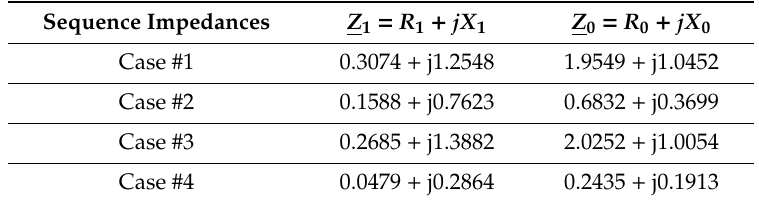
Table 7. Measured positive and zero sequence impedances in Ω .